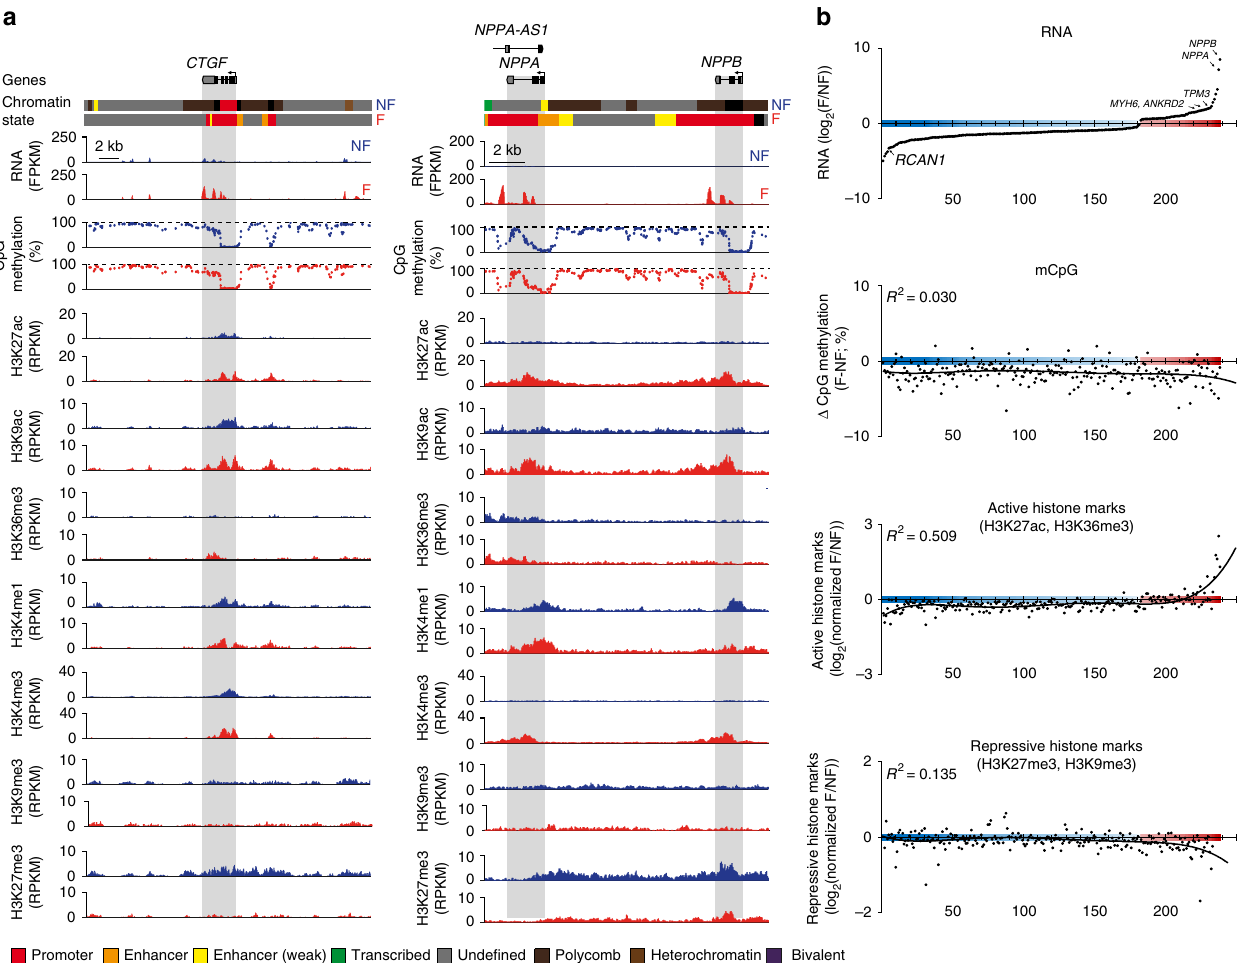
Fig. 3 mCpG and histone pro fi les of genes that are differentially expressed in failing cardiac myocytes. a Original traces of two loci containing connective tissue growth factor ( CTGF ) and the two natriuretic peptide A and B genes ( NPPA and NPPB ). Traces include gene expression, mCpG, histone modi fi cations, and the annotated chromatin state. Genic regions are highlighted in gray. b Differentially expressed genes in cardiac myocyte nuclei of non- failing compared to failing hearts were ranked according to expression changes (top panel). The relative enrichment of active (H3K27ac, H3K36me3) and repressive (H3K9me3, H3K27me3) histone marks together with changes in mCpG are shown for the ranked genes. Resulting R 2 -values of a non-linear regression (black line) are indicated in each graph. Representative genes of the fetal gene program are labeled in bold letters. Figures show data from n biological replicates: mCpG, n = 5; H3K27ac, H3K9ac, H3K36me3, H3K4me1, H3K4me3, H3K27me3, and H3K9me3, n = Fig. 10n, o). To speci fi cally analyze the characteristics of genes